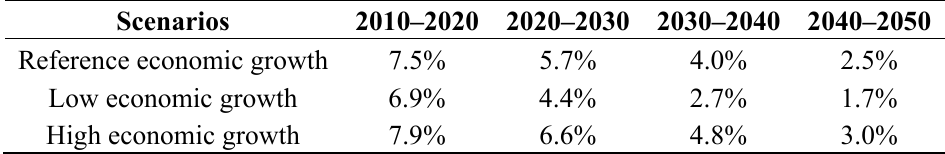
Table 1. Economic growth rates for the three scenarios during different